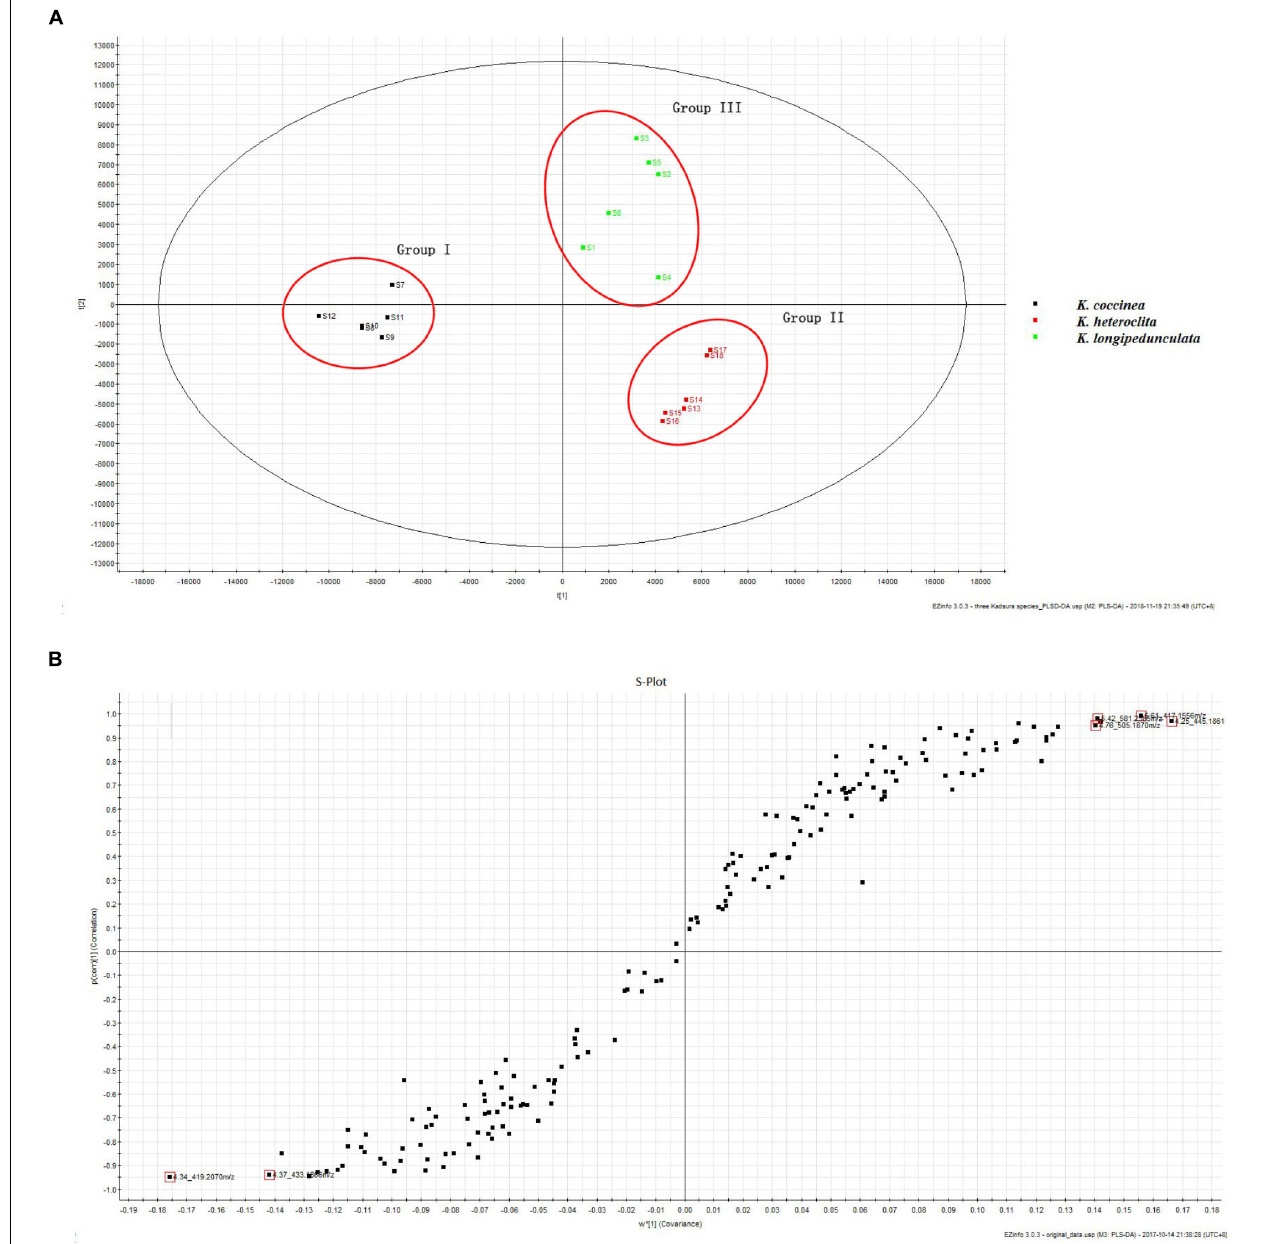
FIGURE 5 | The PLS-DA (A) and S-Plot (B) of K. longipedunculata , K. coccinea and K. heteroclita